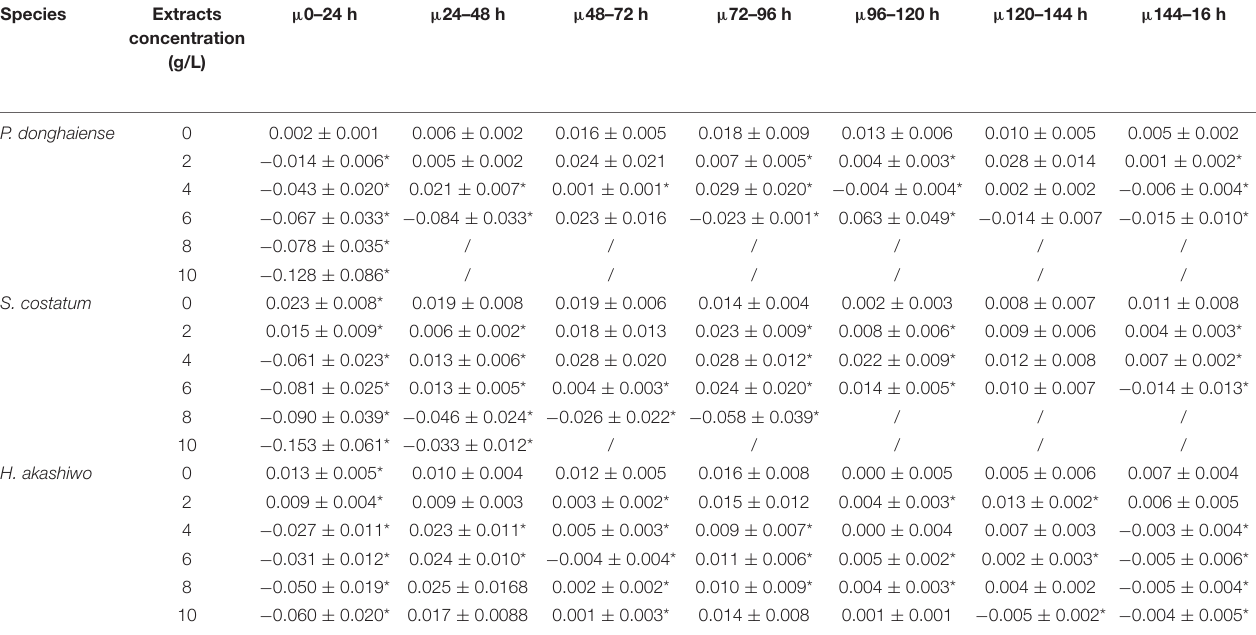
TABLE 3 | The relative growth rate of high density microalgae under the influence of different high concentrations of extracts ( µ ) (h − 1 ). Species Extracts concentration